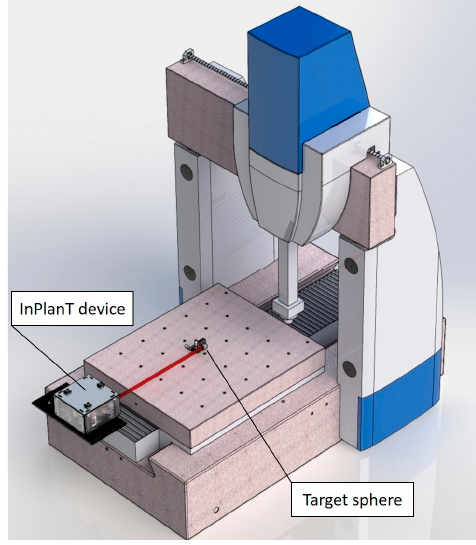
Figure 12. Schematic of the testing set up of the P3 on the CMM.